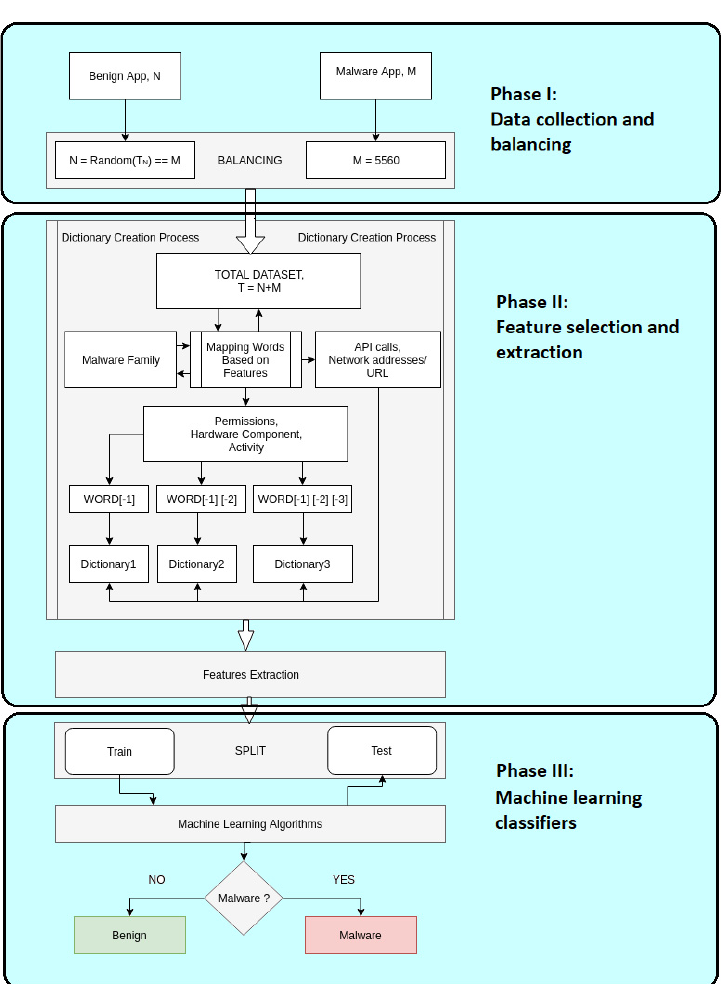
Fig. 1. An overview of feature extraction and selection using SBFS